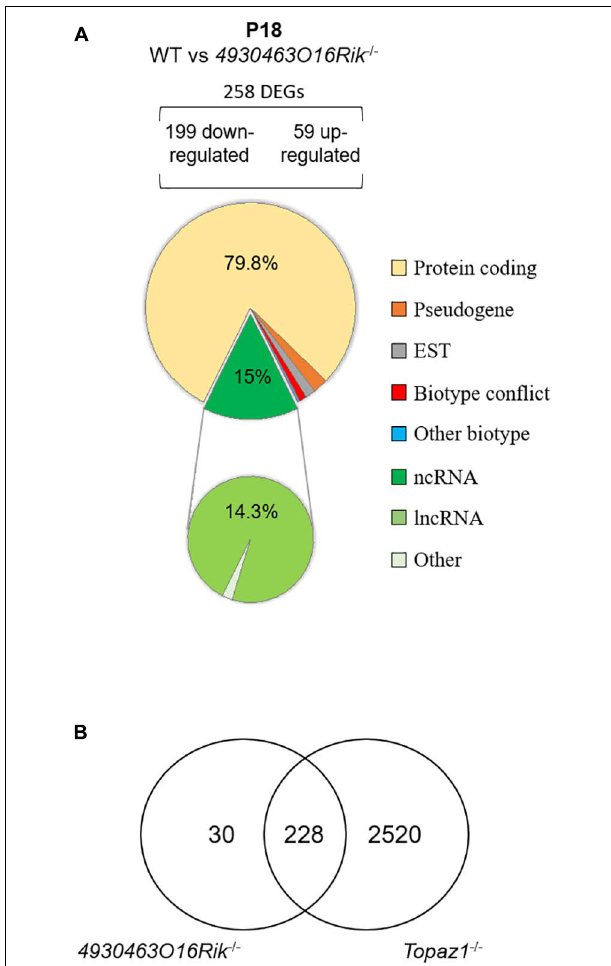
FIGURE 7 | Deregulated genes from 4930463O16Rik − / − mouse testes. (A) Biotype of differentially expressed genes at P18 in 4930463O16Rik − / − testes. Most of the deregulated genes are coding protein genes [adjusted p < 0.05 and down-regulated FC < 2 (log2FC < –1) or up-regulated FC > 2 (log2FC > 1]. (B) Venn diagram showing the overlap of differentially expressed genes between 4930463O16Rik − / − and Topaz1 − / − mouse testes at 18 d pp